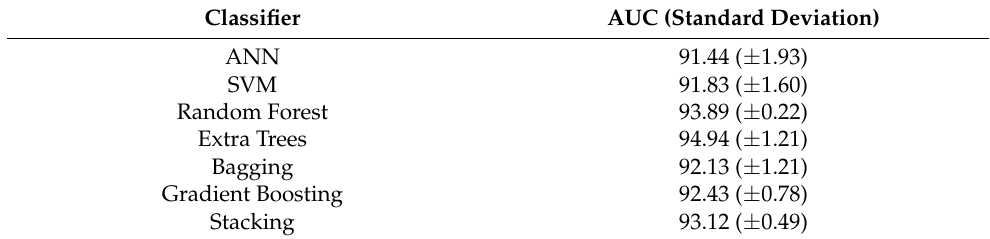
Table 5. AUC results for all classifiers.